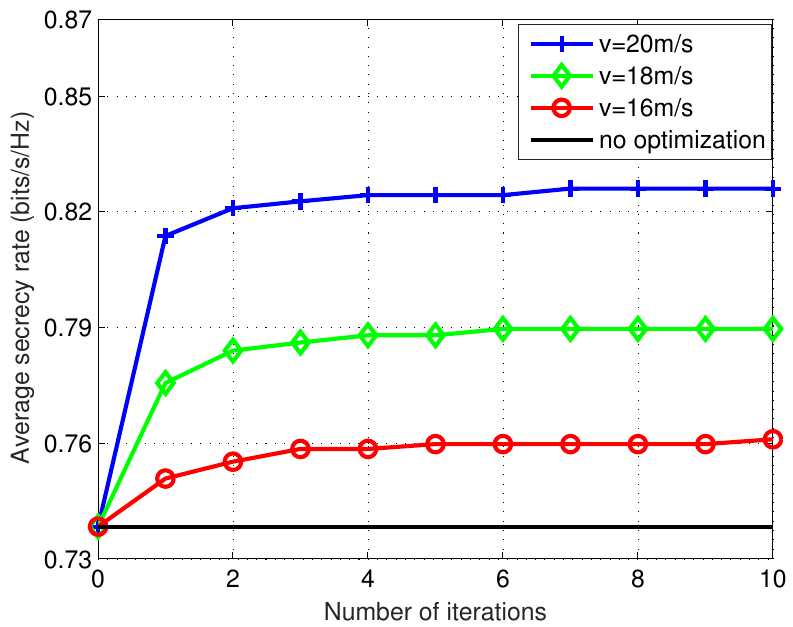
Figure 2. Convergence of the average secrecy rate performance with different maximum UAV speed values. The total flight time is T = 80 s. The proposed algorithm exhibits fast convergence property in all the scenarios examined. Higher maximum UAV speed results in higher average secrecy rate